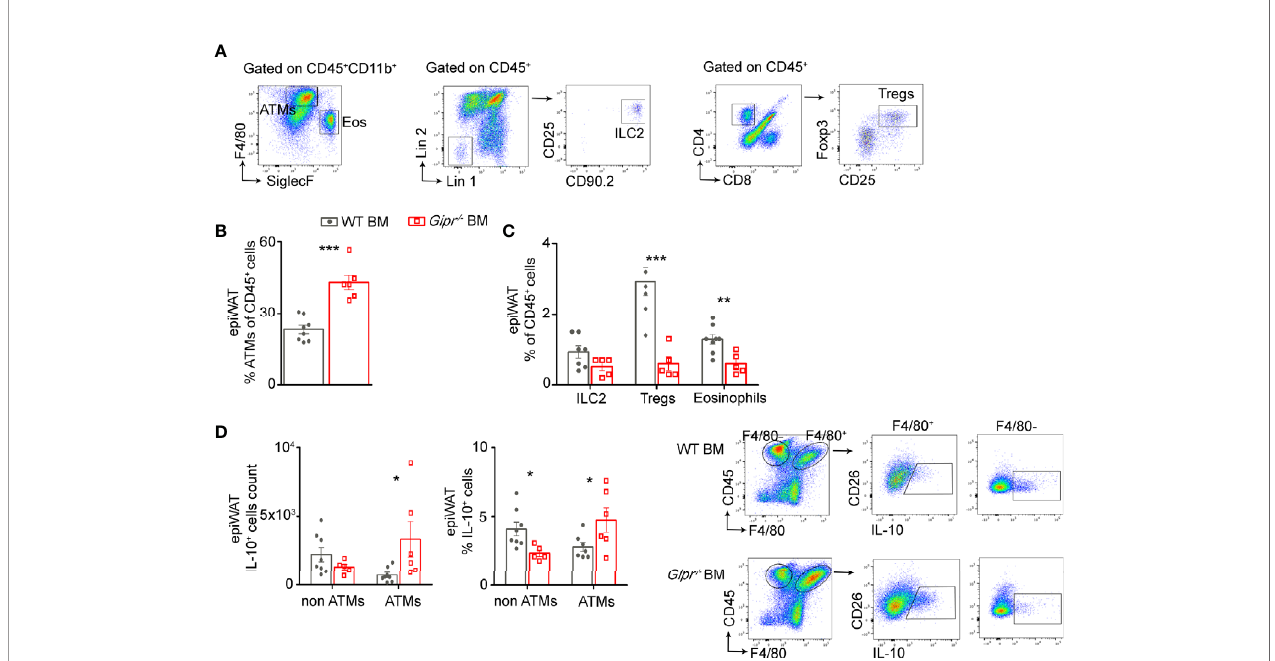
FIGURE 2 | Reduced frequency of type 2 immune cells in the obese epiWAT of Gipr -/- BM mice. Mice were reconstituted with WT BM (gray circles) or Gipr -/- BM (red squares) for 6 weeks and then fed a HFD for 14 weeks (n ≥ 6). (A) Representative fl ow cytometry dot plots showing gating strategy for immune cell populations fi rst gated on living CD45 + cells from epiWAT. ATMs were identi fi ed as CD11b + F4/80 + CD64 + . Eosinophils were de fi ned as CD11b + SiglecF + SSC hi ; ILC2 as Lin - CD25 + CD90.2 + IL-33R + and Tregs as CD4 + CD8 - CD25 + FOXP3 + . (B) Graph showing fl ow cytometry assessment of ATMs fraction out of total CD45 + . (C) Fraction of ILC2, Tregs and Eos out of total CD45 + cell population. (D) Proportion and numbers of IL-10 + cells among ATMs (F4/80 + ) and non-ATMs (F4/80 - ) cell populations, normalized to tissue mass in the epiWAT of HFD-fed chimeras. Right panel, representative fl ow cytometry images depicting the IL-10 + F4/80 + and IL-10 + F4/80 - immune cells. Data are analyzed by unpaired, two-tailed t -test, comparing between WT BM and Gipr -/- BM groups, and are presented as mean ± SEM. *p ≤ 0.05, **p ≤ 0.01 and ***p < 0.001 ATMs, adipose tissue macrophages; ILC2, innate lymphoid cells type 2; Eos, eosinophils; Tregs, T-regulatory